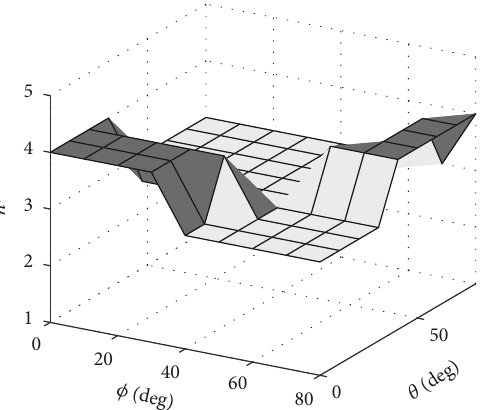
Figure 6: The minimum number of maneuvers given arbitrary target attitudes ( ψ = 30 ∘ ).